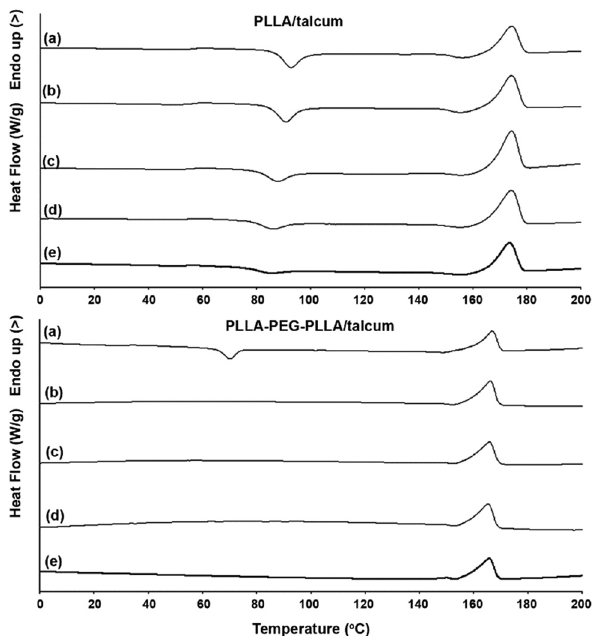
Figure 2: DSC heating curves of ( above ) PLLA/talcum and ( below ) PLLA - PEG - PLLA/talcum composites ( a ) without talcum and with talcum contents of ( b ) 1, ( c ) 2, ( d ) 4, and ( e ) 8